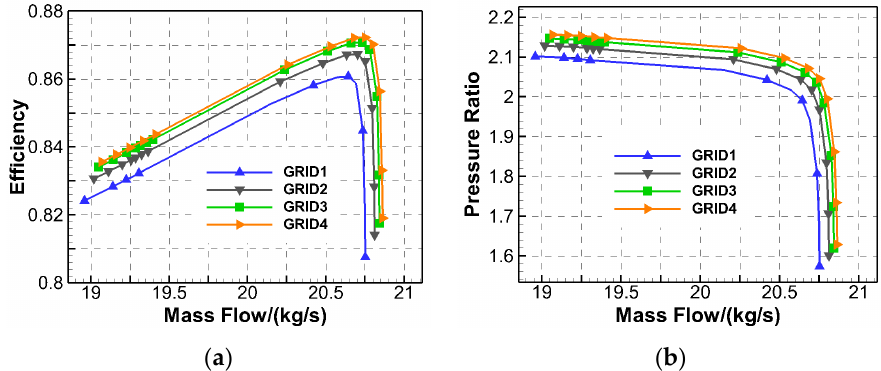
Figure 1. The isentropic efficiency and total pressure ratio of Rotor37 in different grid nodes. ( a ) The isentropic efficiency; ( b ) the total pressure ratio. ( a ) The isentropic e ffi ciency; ( b ) the total pressure